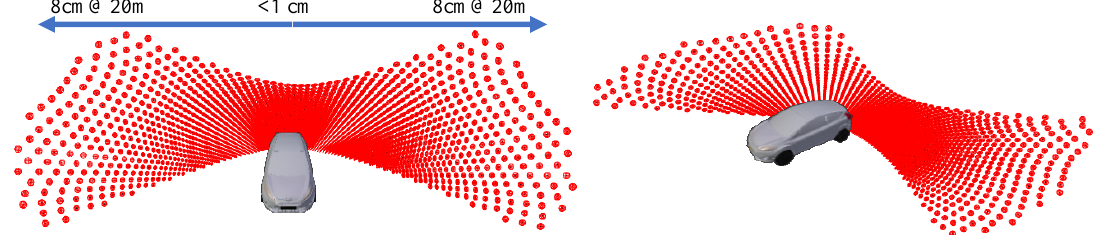
Figure 5. Errors representation of a scanned road surface by a single multi beam Lidar mounted at the rear part of a car roof.